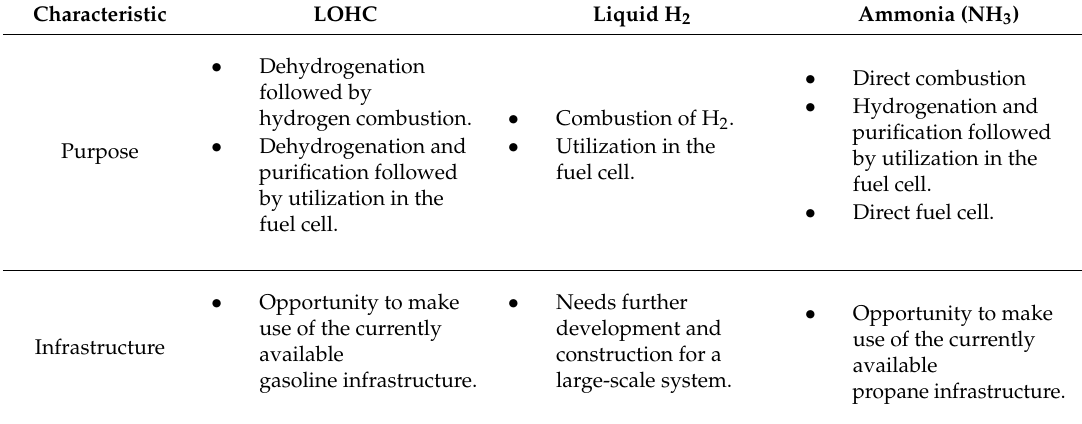
Table 3. Comparison of various hydrogen-storage techniques